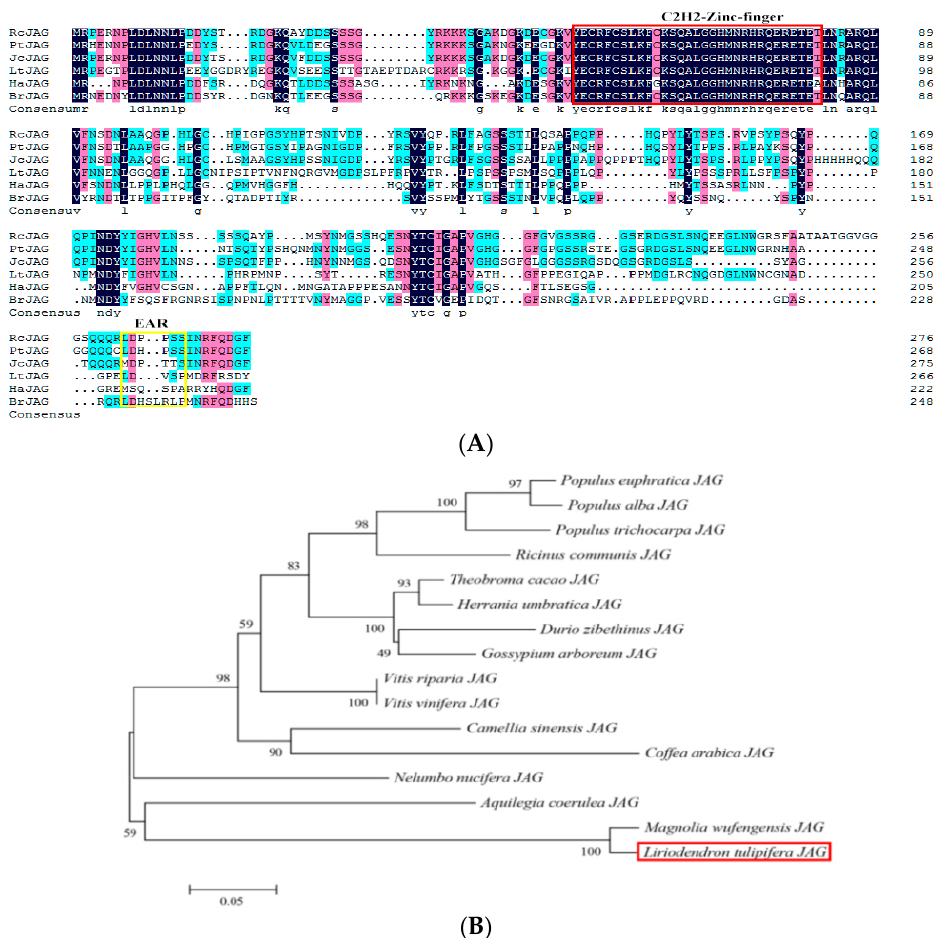
Figure 2. Sequence and phylogenetic analyses of LtuJAG protein. ( A ) The multiple sequence alignment of LtJAG protein with JAG-like protein in Ricinus communis (RcJAG, XP_025015302.1); Populus trichocarpa (PtJAG, XP_024466075.1); Jatropha curcas (JcJAG, XP_020538088.1); Helianthus annuus (HaJAG, XP_021975637.1); Brassica rapa (BrJAG, XP_009105303.1). The highly conserved core sequence Homeodomain is represented by a red box. The EAR motif is indicated by a yellow box; ( B ) Phylogenetic relationships among JAG proteins from different plant species. LtuJAG is indicated by the red box.